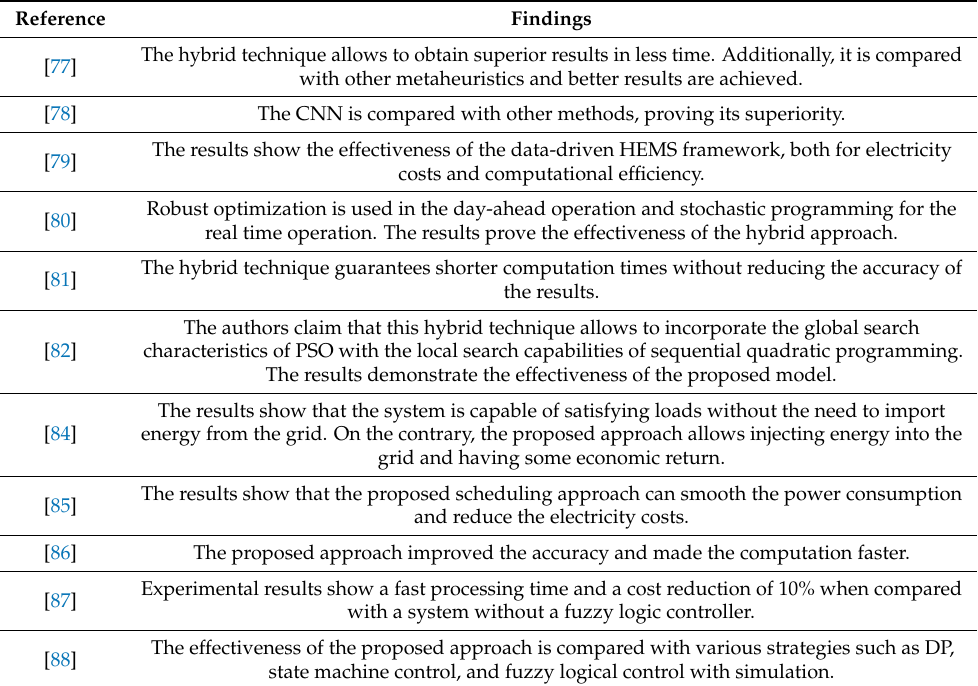
Table 16. Findings of selected papers associated with the other techniques